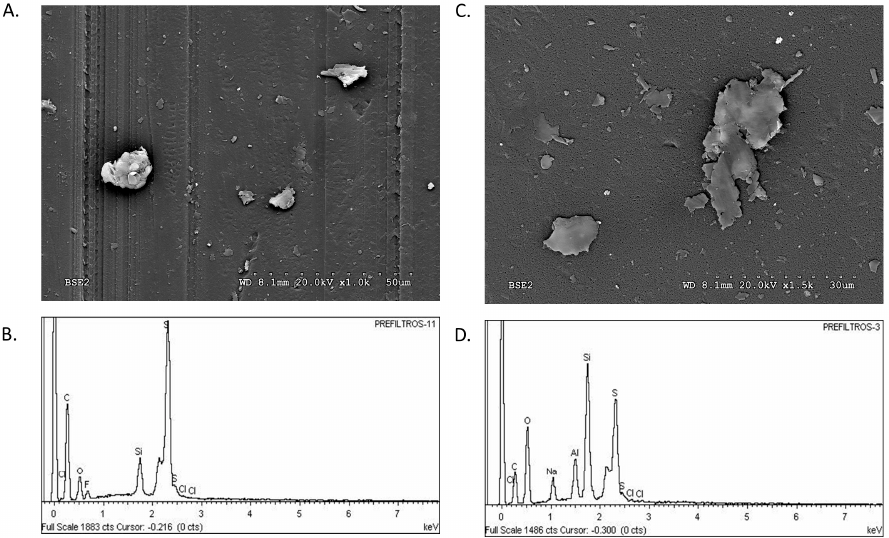
Figure 3. Electron microscopy images of particles found on ultrafilters from dialysis center 1. ( A ) General view of deposits on the membrane. ( B ) Elemental chemical composition. ( C ) Magnification of deposit scales on the membrane. ( D ) Elemental chemical composition of contaminant shown in ( C ).